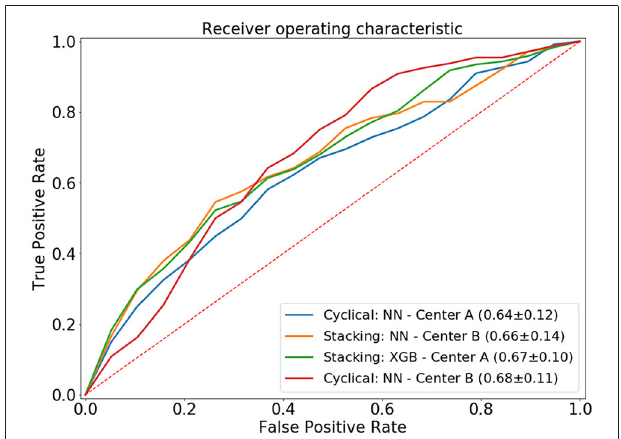
FIGURE 4 | Average ROC curve (standard deviation) of the 20-fold cross-validation for the distributed and combined local models. NN, neural network; XGB, XGBoost.